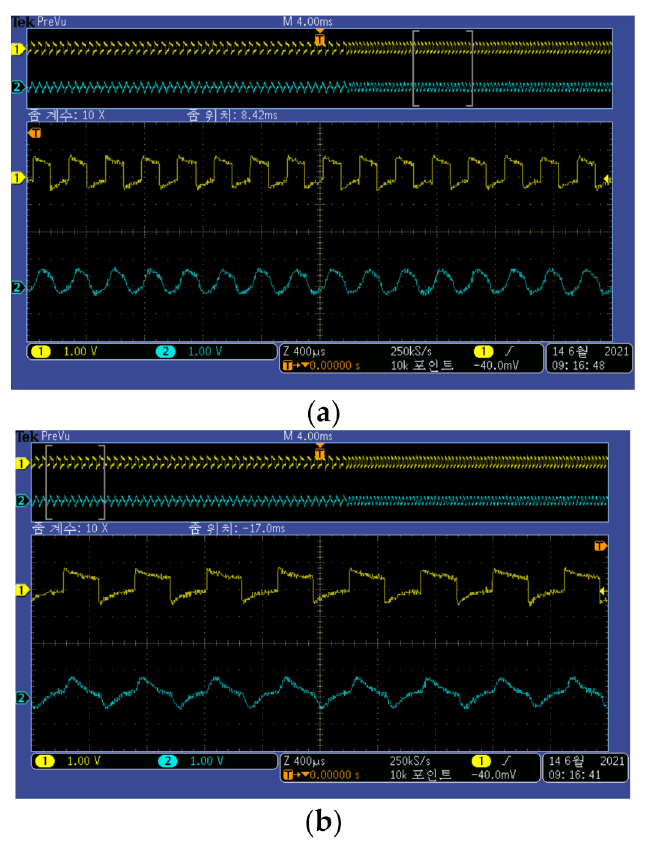
Figure 30. Expansion of Figure 29: ( a ) 4 kHz region; ( b ) 2 kHz